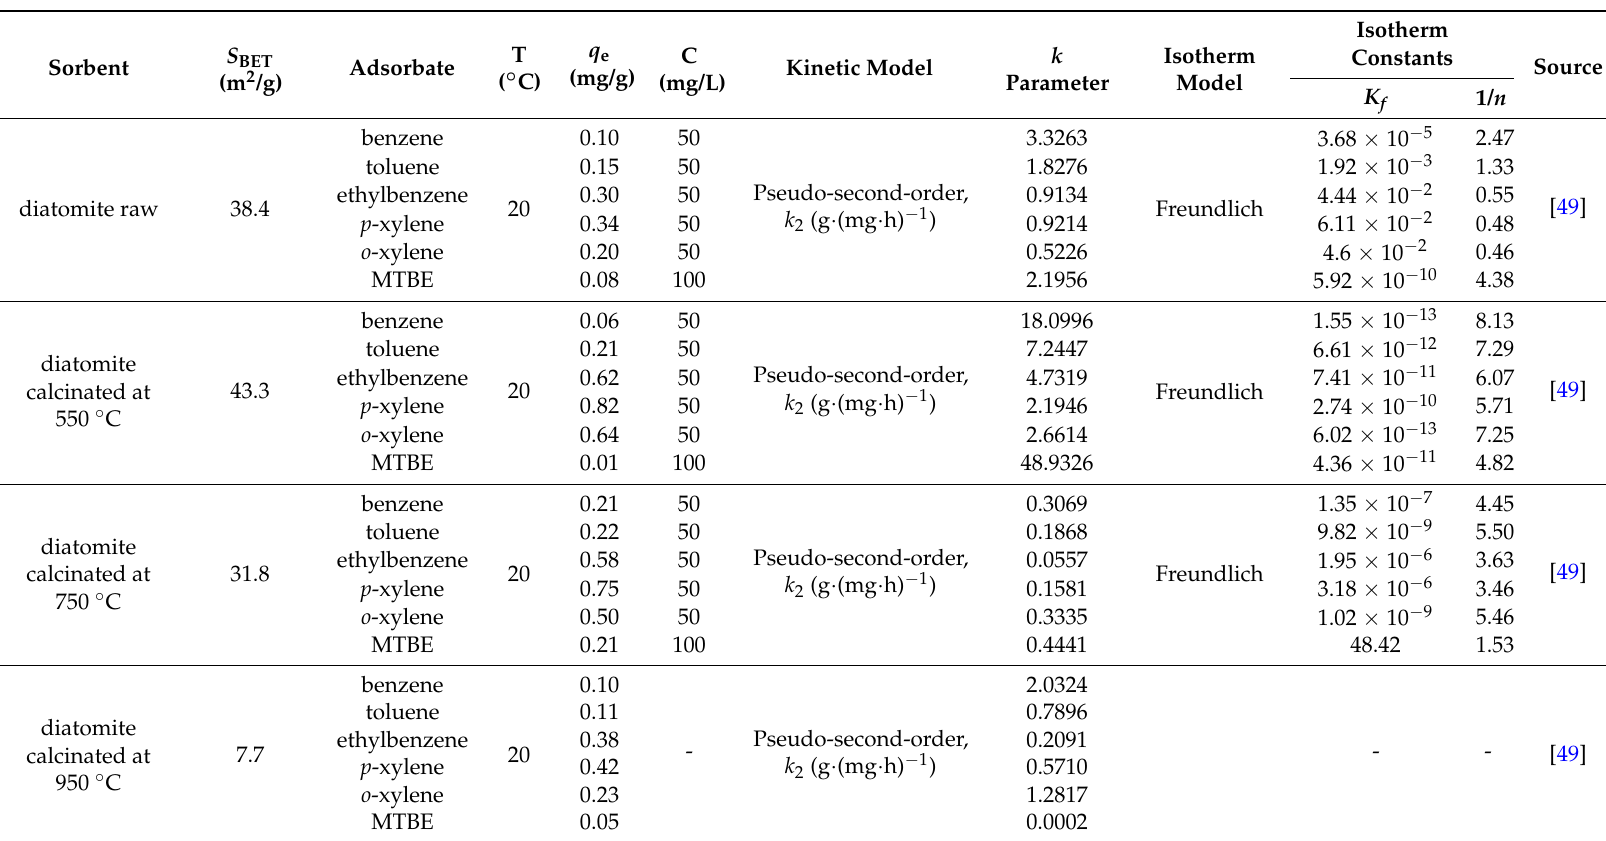
Table 2. Sorption capacities ( q e ) of selected adsorbents towards volatile organic compounds present in aqueous solutions and the most suitable kinetic and isotherm models with